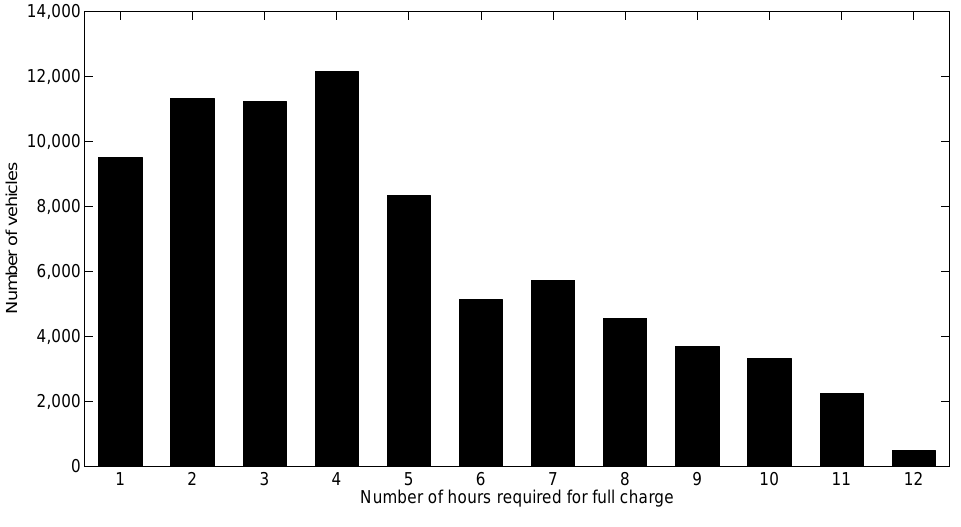
Figure 8. Number of cars in each charging